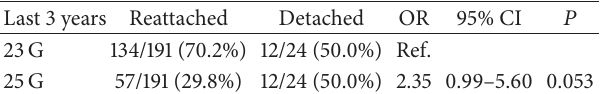
Table 6: Comparison between 23 and 25 G in last 3 years of the study.